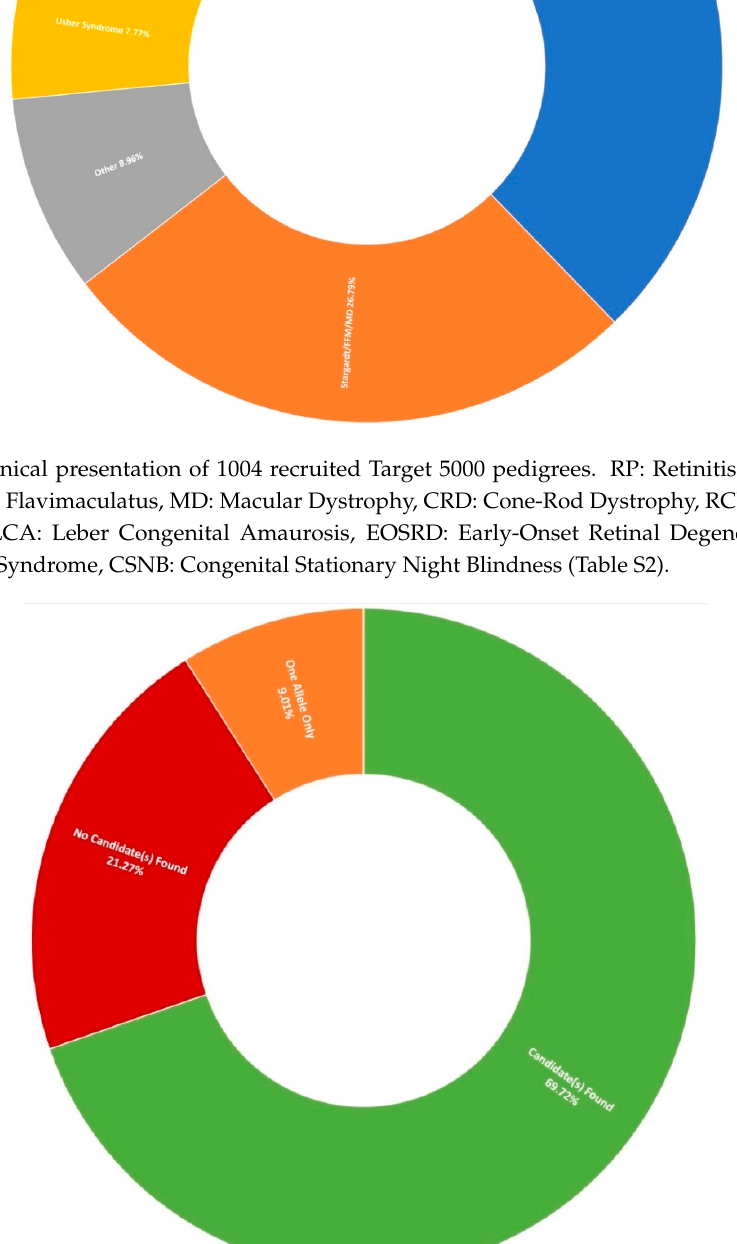
Figure 2. Diagnostic yield rates for 710 Target 5000 pedigrees utilising target capture next-generation sequencing of the exonic regions of over 250 genes and previously identified pathogenic intronic variants (Table S3).